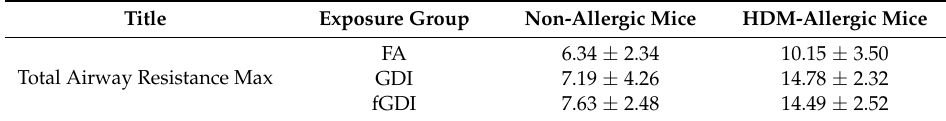
Table 1. Exposure to GDI engine exhaust increases total respiratory system resistance. The maximum resistance achieved in response to 100 mg/mL methacholine across the total airway, as well as the peripheral and central tissues for non- and HDM-allergic animals, is summarised as means ± SDs for 8 to 9 mice per